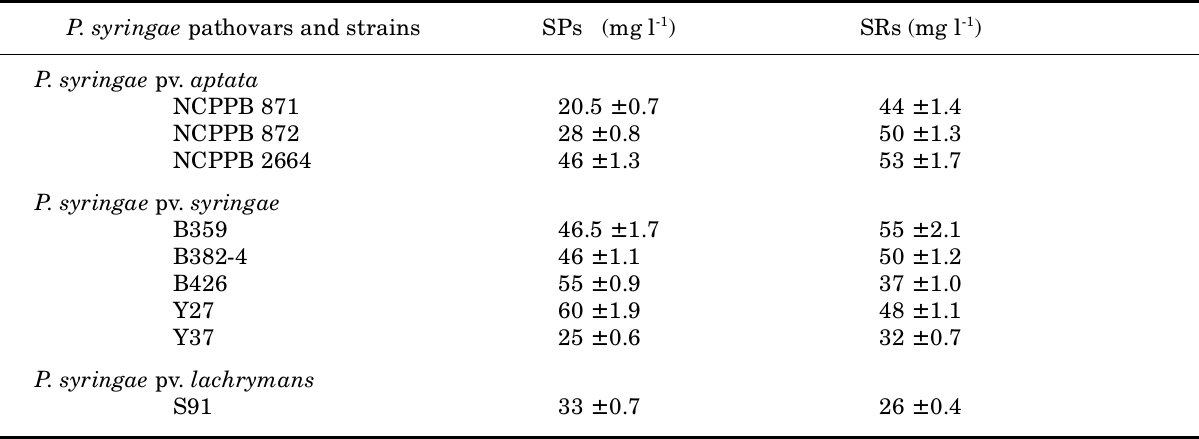
Table 1. Concentration of syringopeptins (SPs) and syringomycins (SRs) in 5-day-old culture filtrates of nine strains of three pathovars of Pseudomonas syringae a